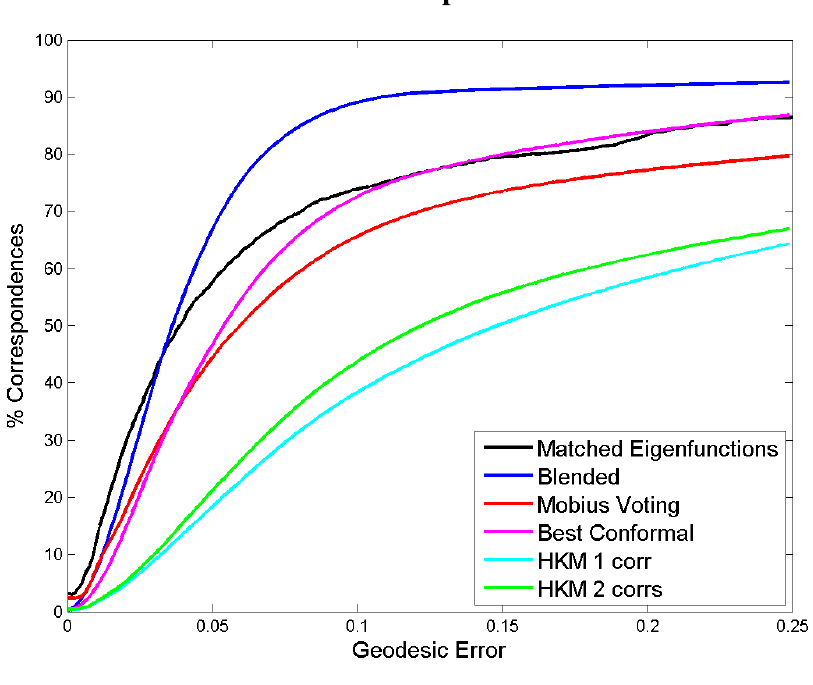
Figure 8. Evaluation of the proposed correspondence framework applied to shapes from the SCAPE database, using the protocol of